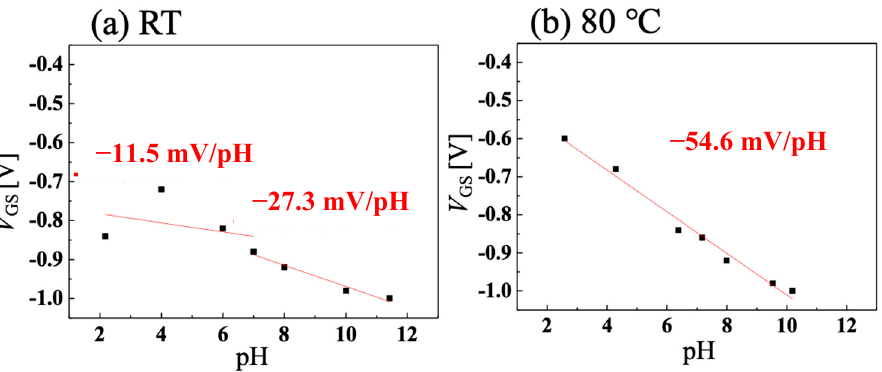
Figure 7. pH sensitivity calculated from Figure 6a,b when solution temperature is ( a ) room temper ‐ ature and ( b ) 80 °C.